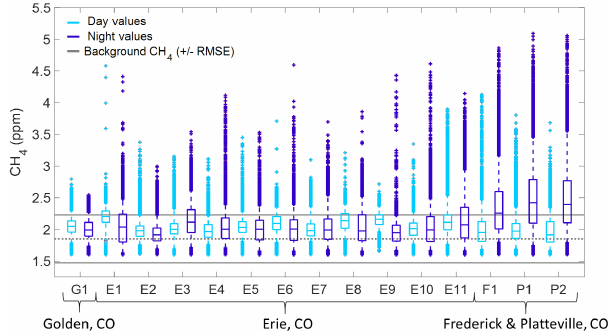
Figure 16. Box plots of all data for each U-Pod, grouped into day- time and nighttime values. Note that whiskers are the 5th and 95th percentile values. These U-Pods are then further grouped by